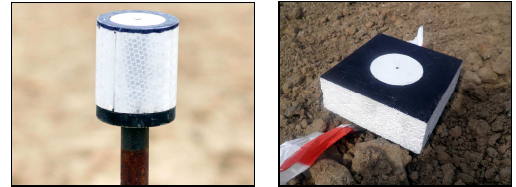
Figure 2. Self-built GCP for UAV and TLS